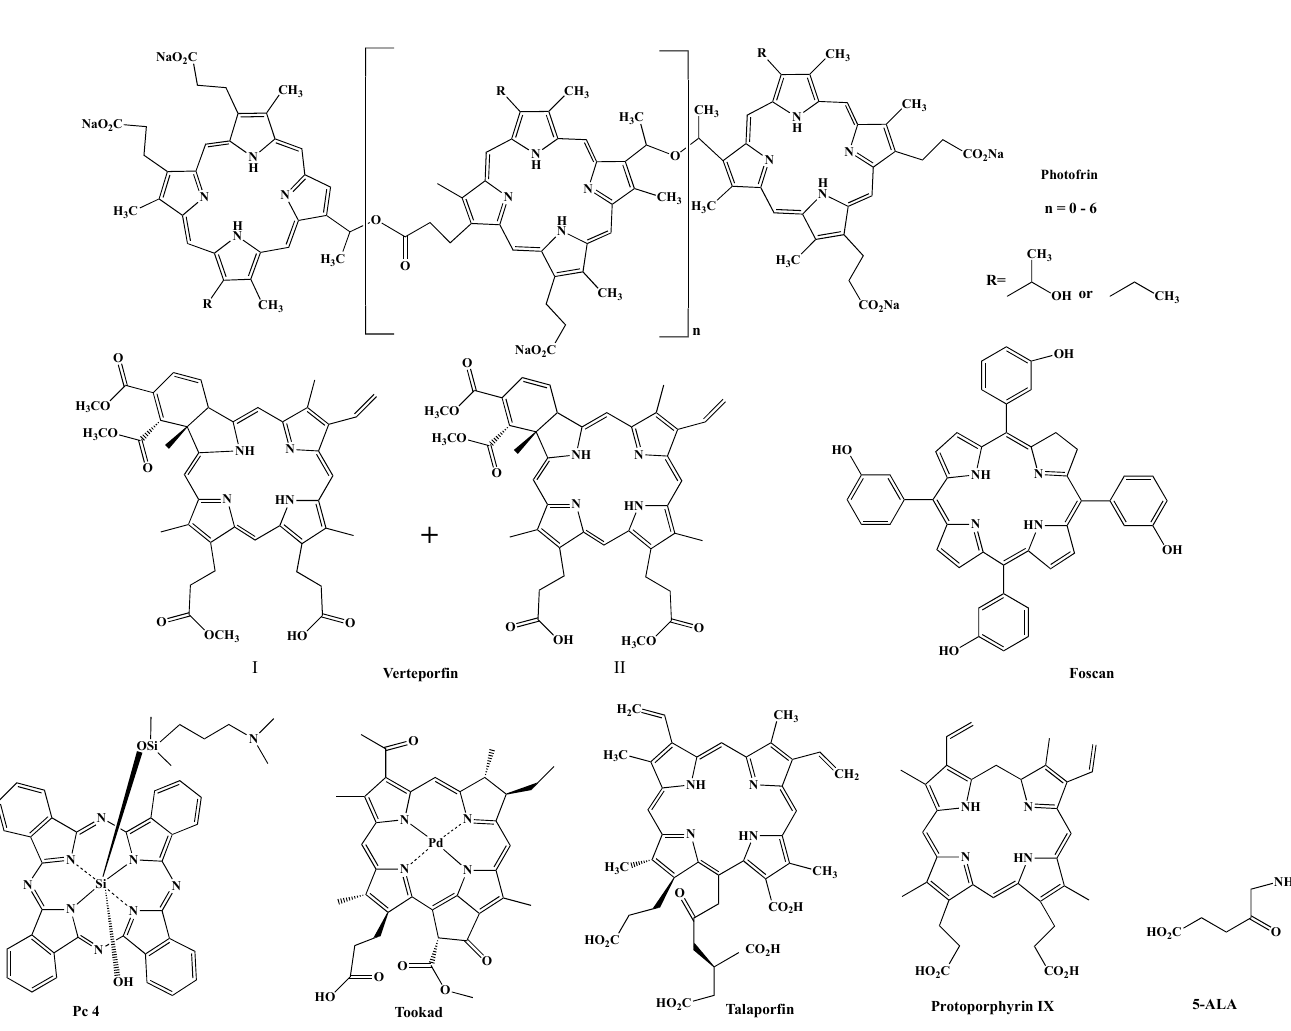
Figure 2. Structures of some photosensitizers and protoporphyrin IX precursor 5-ALA. Table 1. Summary of photosensitizers in clinical use.